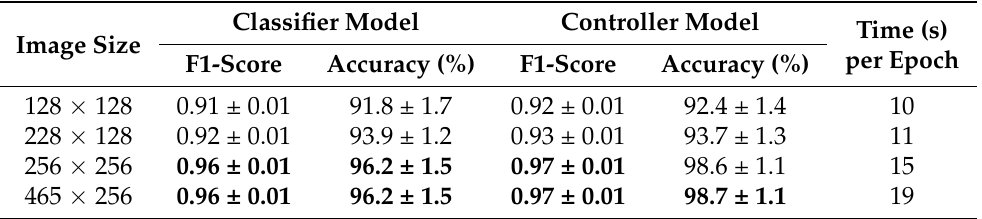
Table 6. The classification results of the proposed models with different input image sizes (mean ± std).